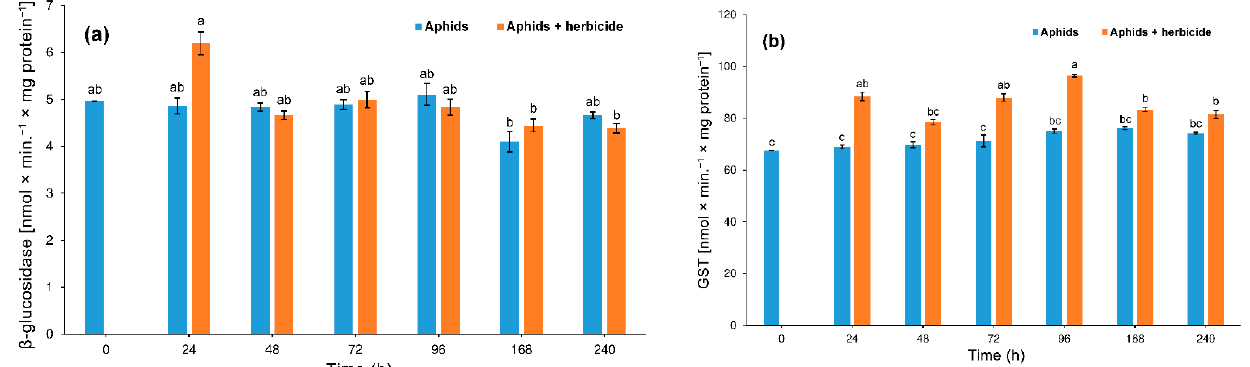
Figure 6. Activity change of β -glucosidase ( a ) and s-glutathione transferase (GST) ( b ) in the tissues of Phorodon cannabis after the application of Pantera 040 EC graminicide to the hemp plant (mean ± SE; control = aphids on the Cannabis sativa ). Values not followed by the same letter are significantly different at the level of p < 0.05 (Tukey multiple range test).